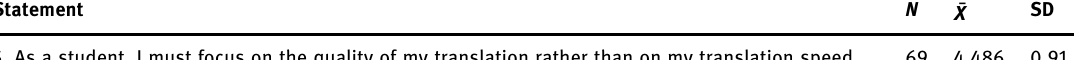
Table 2: Speed and the perception of quality Statement